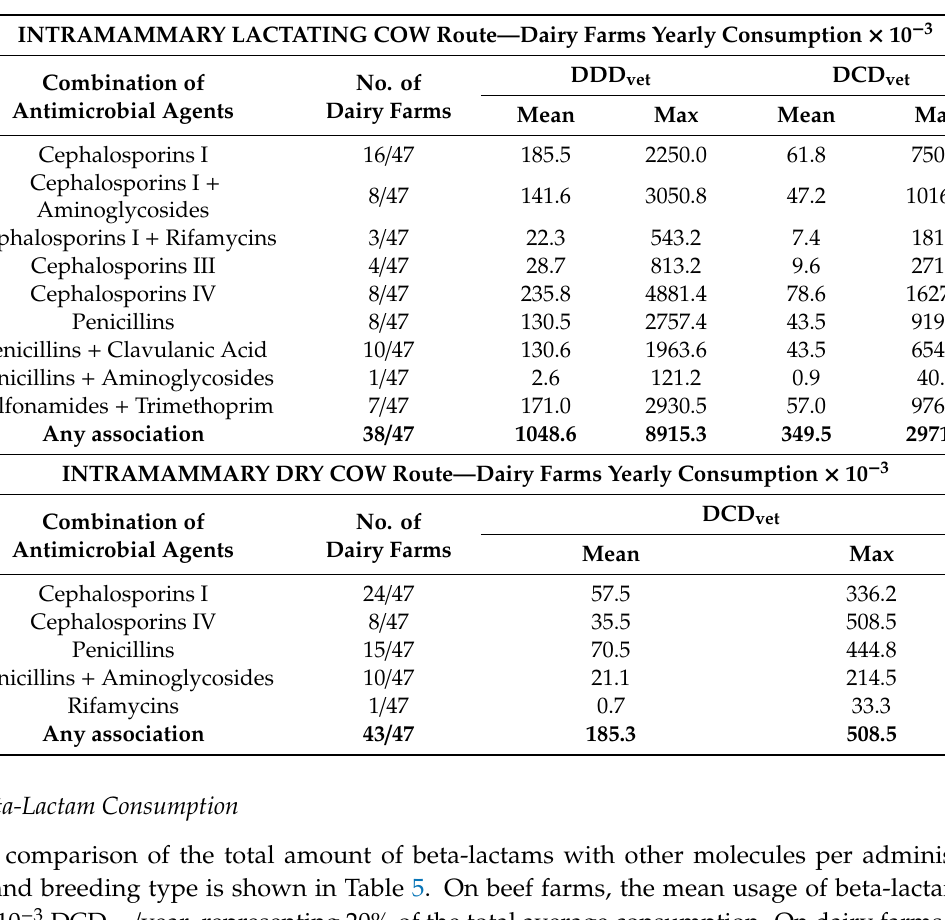
Table 4. Annual consumption (DDD vet / year × 10 − 3 - DCD vet / year × 10 − 3 ) via the intramammary route per combination of antimicrobial agents on dairy farms (single classes or class combinations are listed only if they were part of at least one treatment).